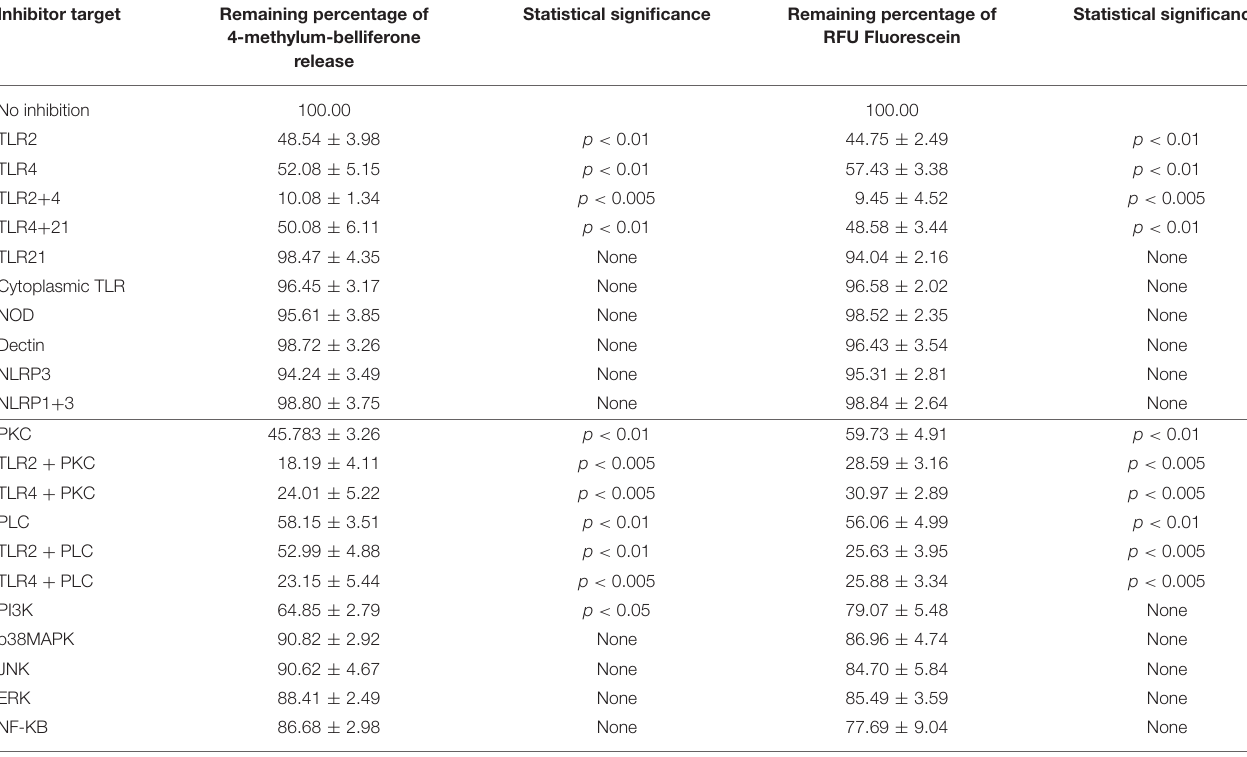
TABLE 2 | Heterophils are activated through TLR2 and TLR4 through PKC and PLC dependent